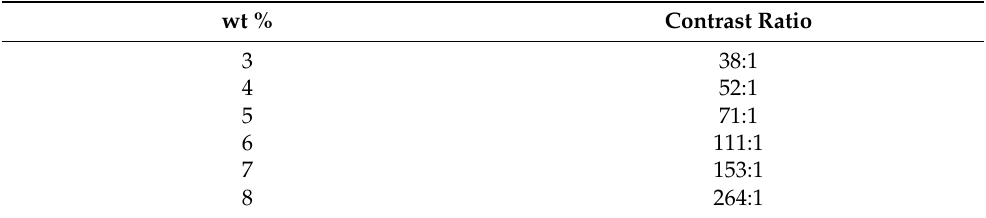
Table 6. Light luminance and calculated contrast ratio of the non-polarized mode transparent OLED display as a parameter of the dye concentration at 10.0 µ m of the cell gap. Light luminance in the OLED area was measured as 4644 cd/m 2